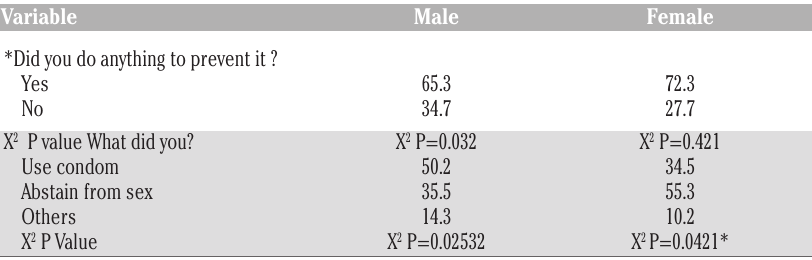
Table 6. Association between communication and risk reduction